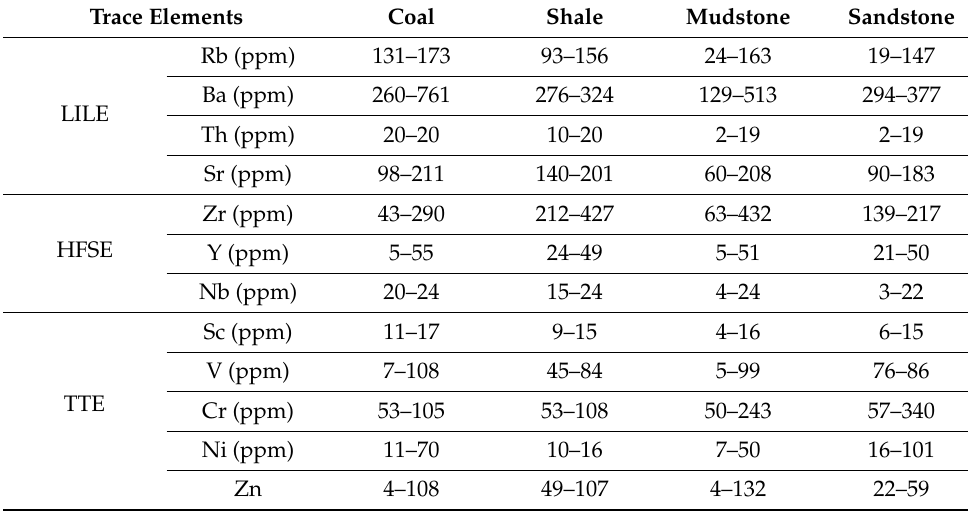
Table 3. Abundances of some trace elements in studied